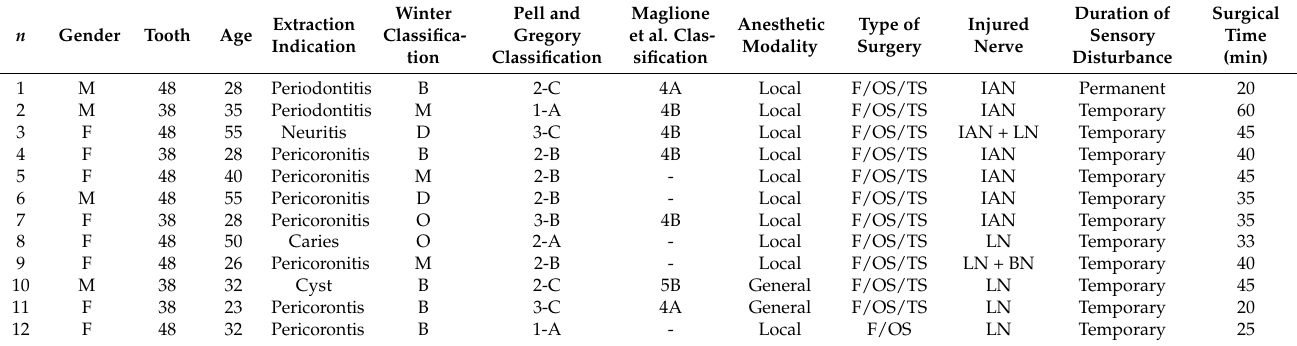
Table 5. Characteristics of the patients who developed neurological